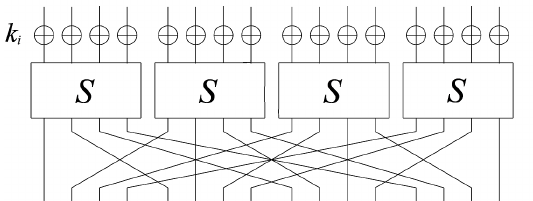
Figure 2: One round SP structure of